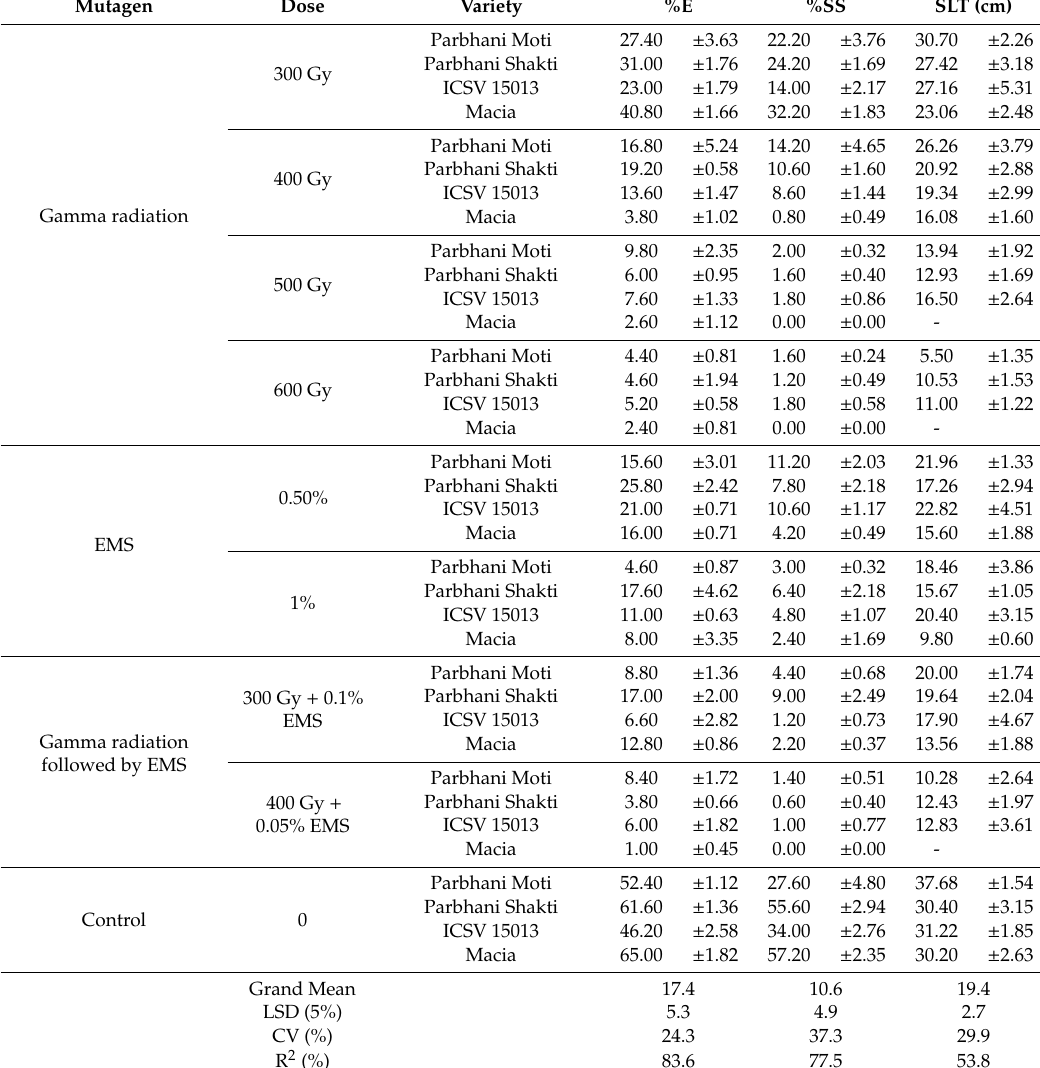
Table 2. Means of emergence percentage (%E), seedling survival percentage (%SS) and shoot length (SLT) among four sorghum genotypes tested using four gamma radiation, two EMS and two subsequent treatments of gamma and EMS in experiment